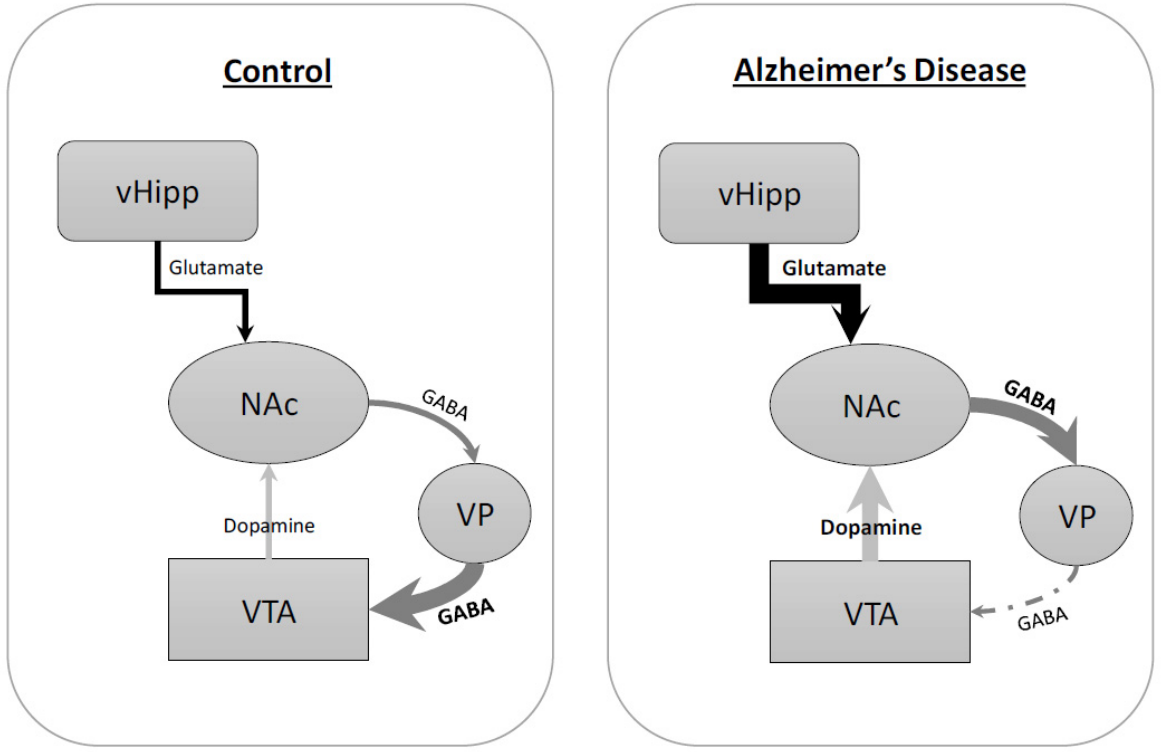
Figure 5. The ventral hippocampus (vHipp) can modulate activity in the ventral tegmental area (VTA) via a multi-synaptic pathway that includes the nucleus accumbens (NAc) and ventral pallidum (VP, left ). In the case of psychosis, hyperactivity in hippocampal subfields can drive aberrant dopamine neuron activity by causing a disinhibition of the VTA by the VP, therefore modulating dopamine neurotransmission ( right ).